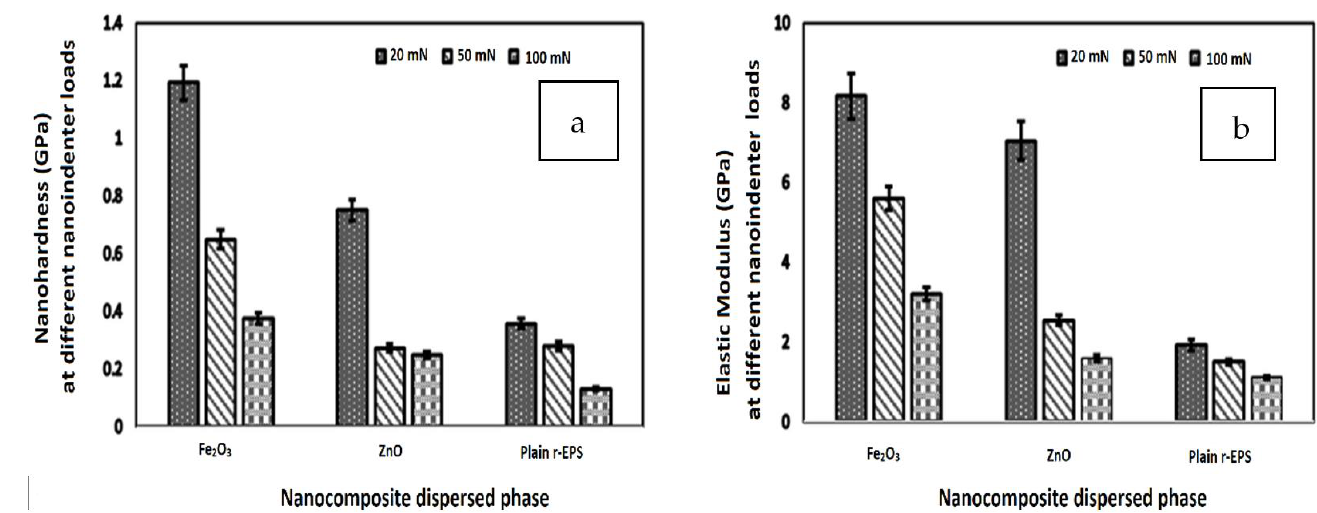
Figure 18. ( a ) Nanohardness and ( b ) elastic modulus under indentation loads of 20, 50, and 100 mN